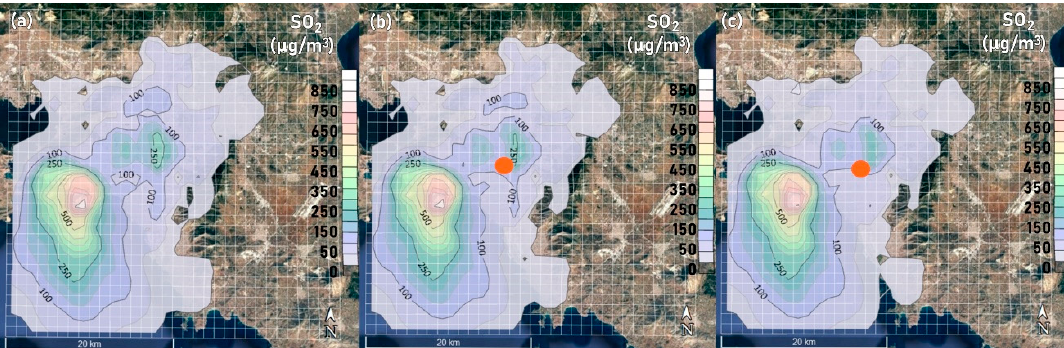
Figure 10. 24 h average PM10 concentration levels calculated in the present study and overlaid on Google Earth imagery (Map data: Landsat/Copernicus, SIO, NOAA, U.S. Navy, NGA, GEBCO) ( a ) before implementation of building energy efficiency scenarios, ( b ) after implementation of scenario a. with wall insulation (location of maximum local reduction is indicated), and ( c ) after implementation of scenario c. involving substitution of heating oil with natural gas.